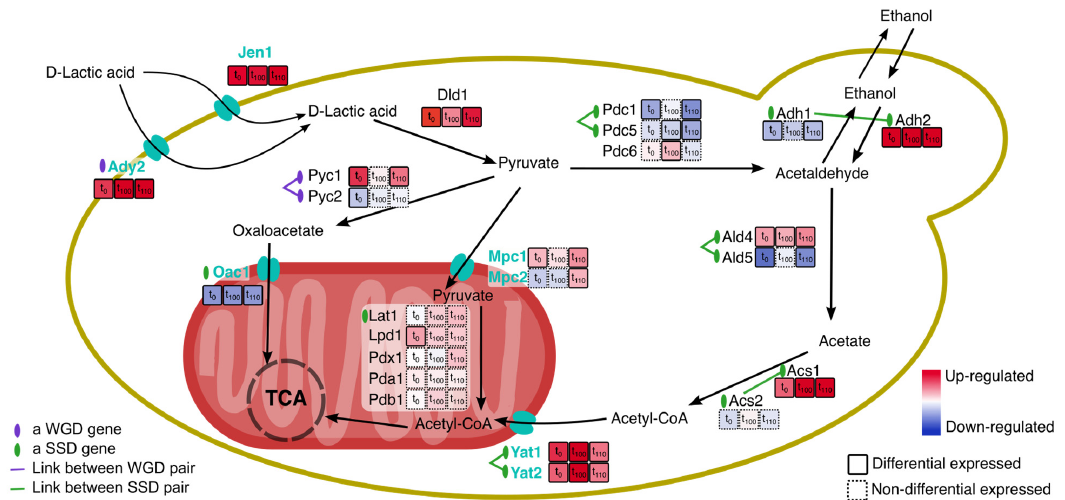
Figure 5. Saccharomyces cerevisiae Y06240 lactic acid/lactate uptake mechanism, with the indication of metabolic, rewire after experimental evolution on YPL. Lactate transporters both in periplasmic and mitochondrial membranes have been indicated in green. Some of the duplicated genes implicated in this lactate uptake and metabolism have been indicated with colors, whereas singletons are in black. Expression level (up in red and down-regulated in blue) and statistical significance (differentially expressed genes in a continuous line, and non-differentially expressed genes in dashed line) of each gene are indicated.